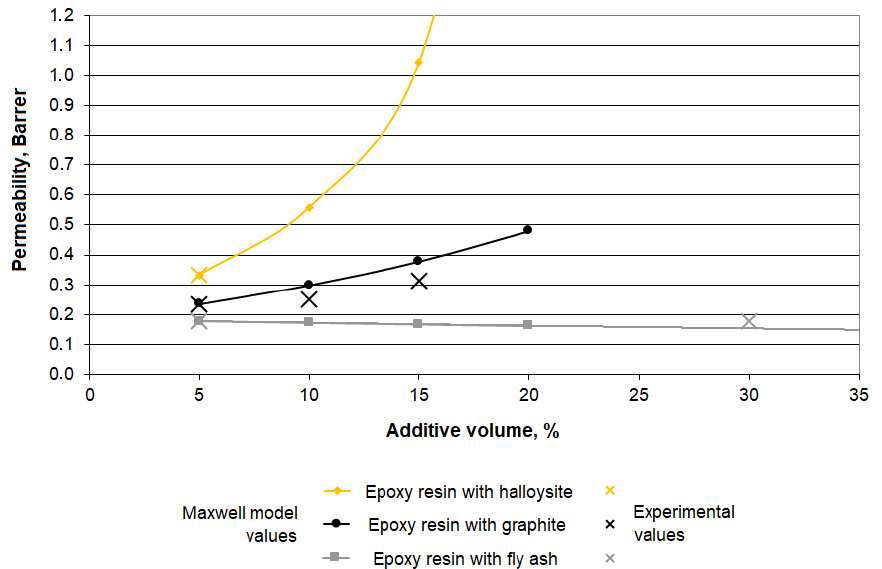
Figure 3. Maxwell model and experimental Figure 3 . Maxwell model and experimental permeabilities.